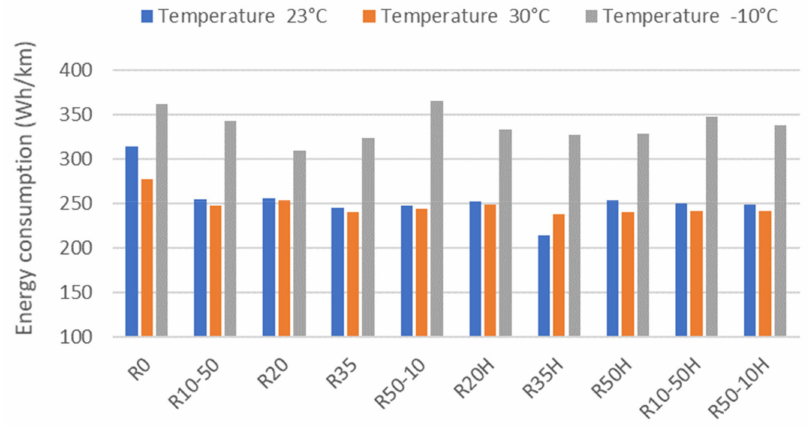
Figure 9. Energy consumption test results under the laboratory legislative cycle. Table 4. Energy consumption test results under the legislative cycle and subjective driving comfort assessment. Regenerative